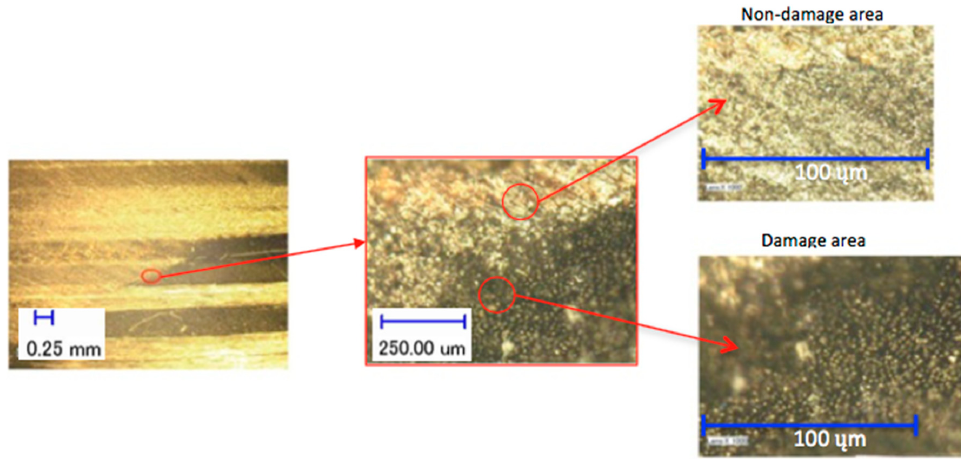
Figure 4. The identification procedure of the damage and non-damage spot/area from laser drilling effects.